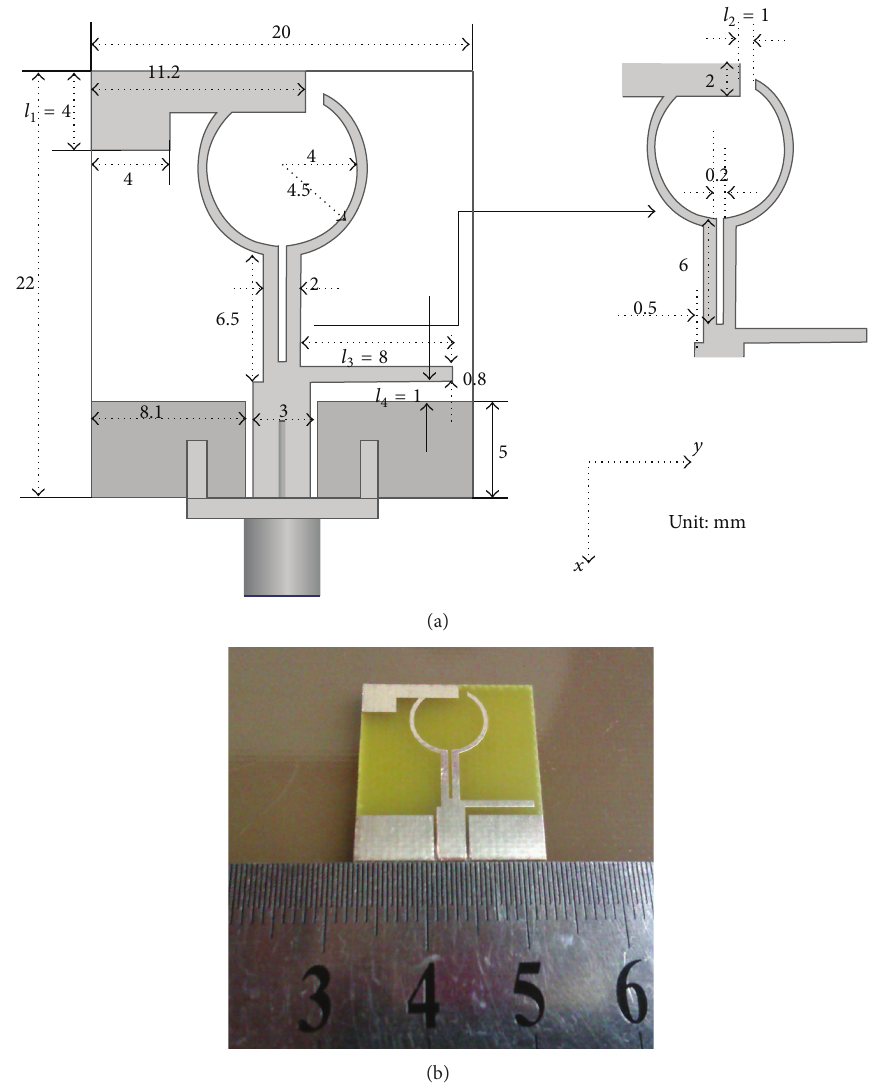
Figure 3: (a) Layout of the proposed triband antenna. (b) Photograph of the fabricated prototype antenna.